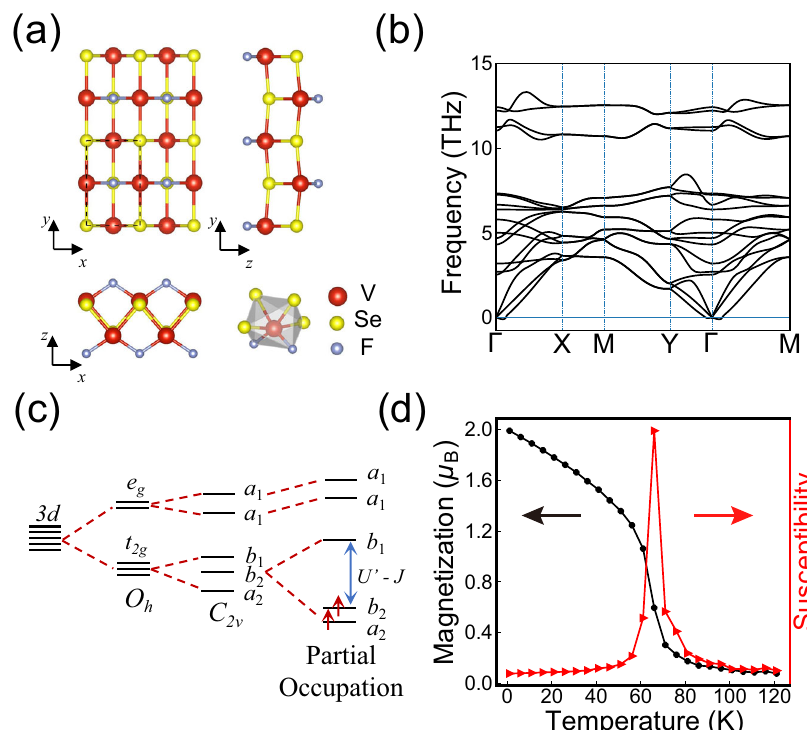
Fig. 1 Structure and magnetic properties of VSeF monolayer. a Top and side views of VSeF monolayer, and a local distorted VSe 4 F 2 octahedron. Red, yellow, and gray balls represent V, Se, and F atoms, respectively. b Phonon spectrum of VSeF monolayer. c The 3 d orbital splitting from an ideal octahedron with O h symmetry to a distorted octahedron with C 2v symmetry, and further splitting with a larger energy gap between occupied states and unoccupied states in V 3 + 3 d 2 due to the electronic correlation. d Simulated magnetic moment (black data) and magnetic susceptibility (red data) as functions of temperature for 2D